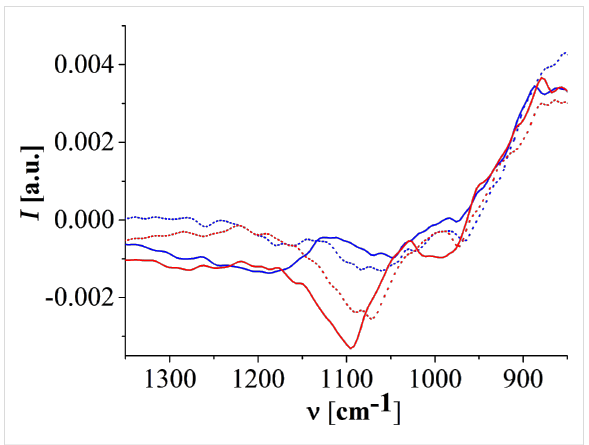
Figure 5: IRRAS spectra (incidence angle 40°, s-polarization) of C1P monolayers on the different subphases (red lines – pH 9 buffer; blue lines – pH 4 buffer; solid line – with calcium; dotted line – without calcium) at 20 mN/m and 30 °C. The spectra are shifted ( y -axis) for better